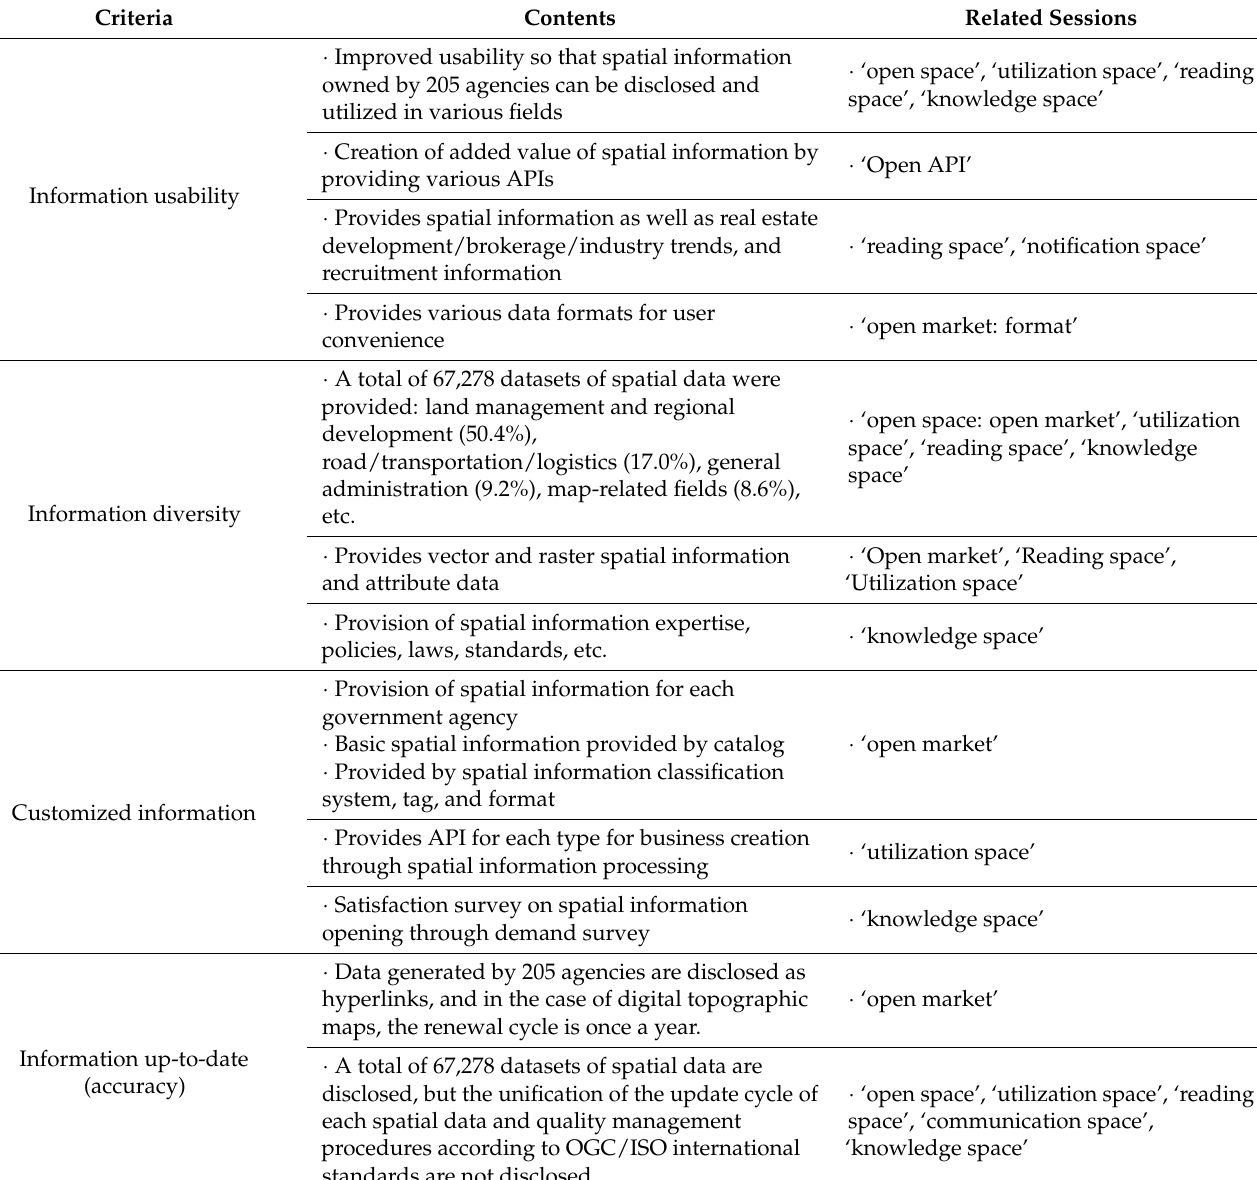
Table 2. NSDIP evaluation of information